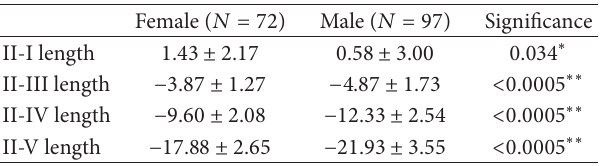
Table 3: Gender differences in metatarsal protrusion. Mean values of metatarsal protrusion expressed in millimeters related to II ray.